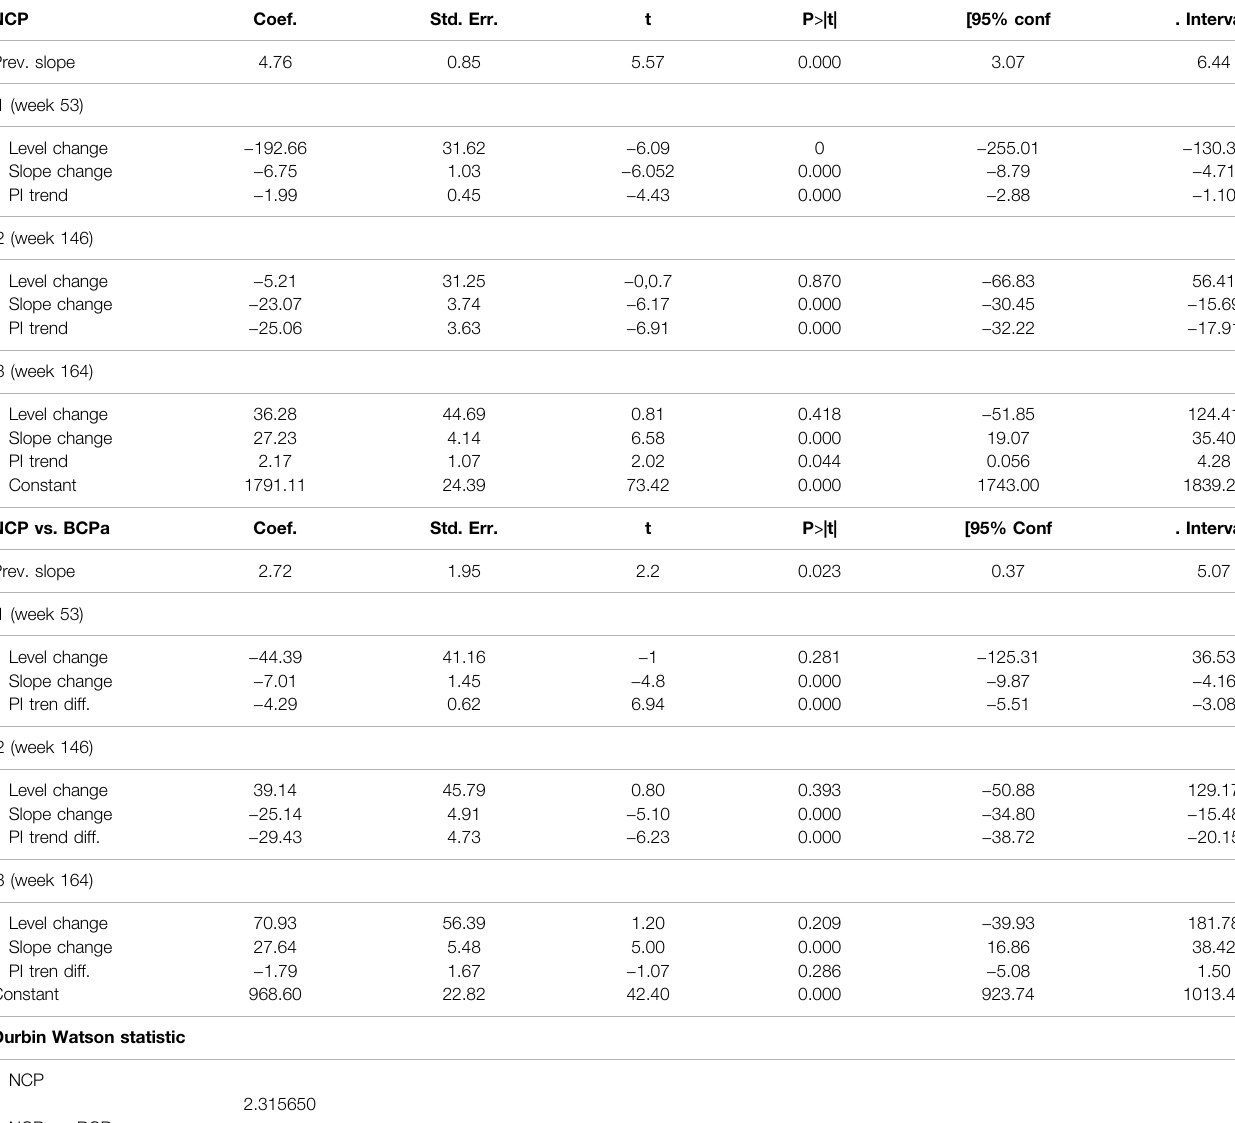
TABLE 1 | Segmented regression parameters for IRF use for NCP and NCP with a control group. NCP Coef. Std. Err. t P > |t| [95% conf .